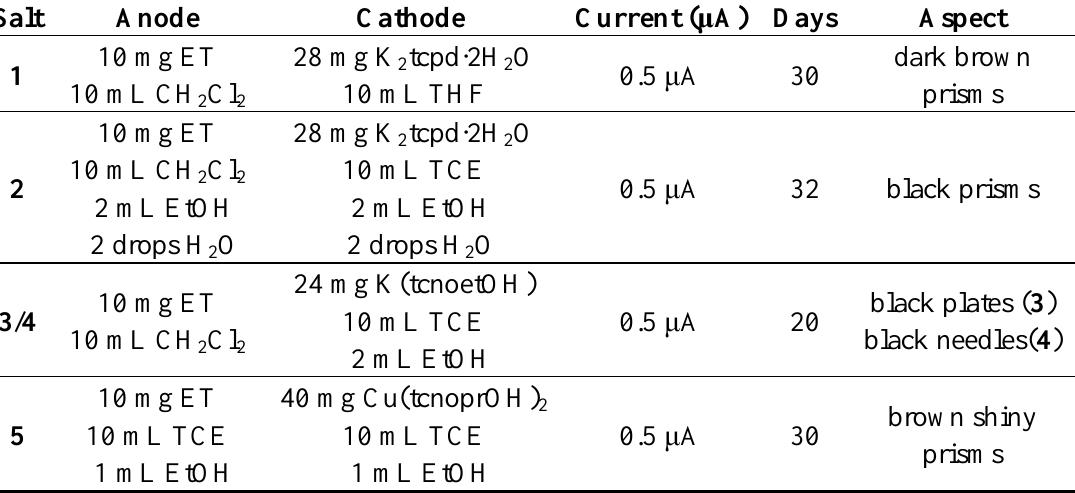
Table 12. Experimental conditions used for the synthesis of compounds 1 – 5